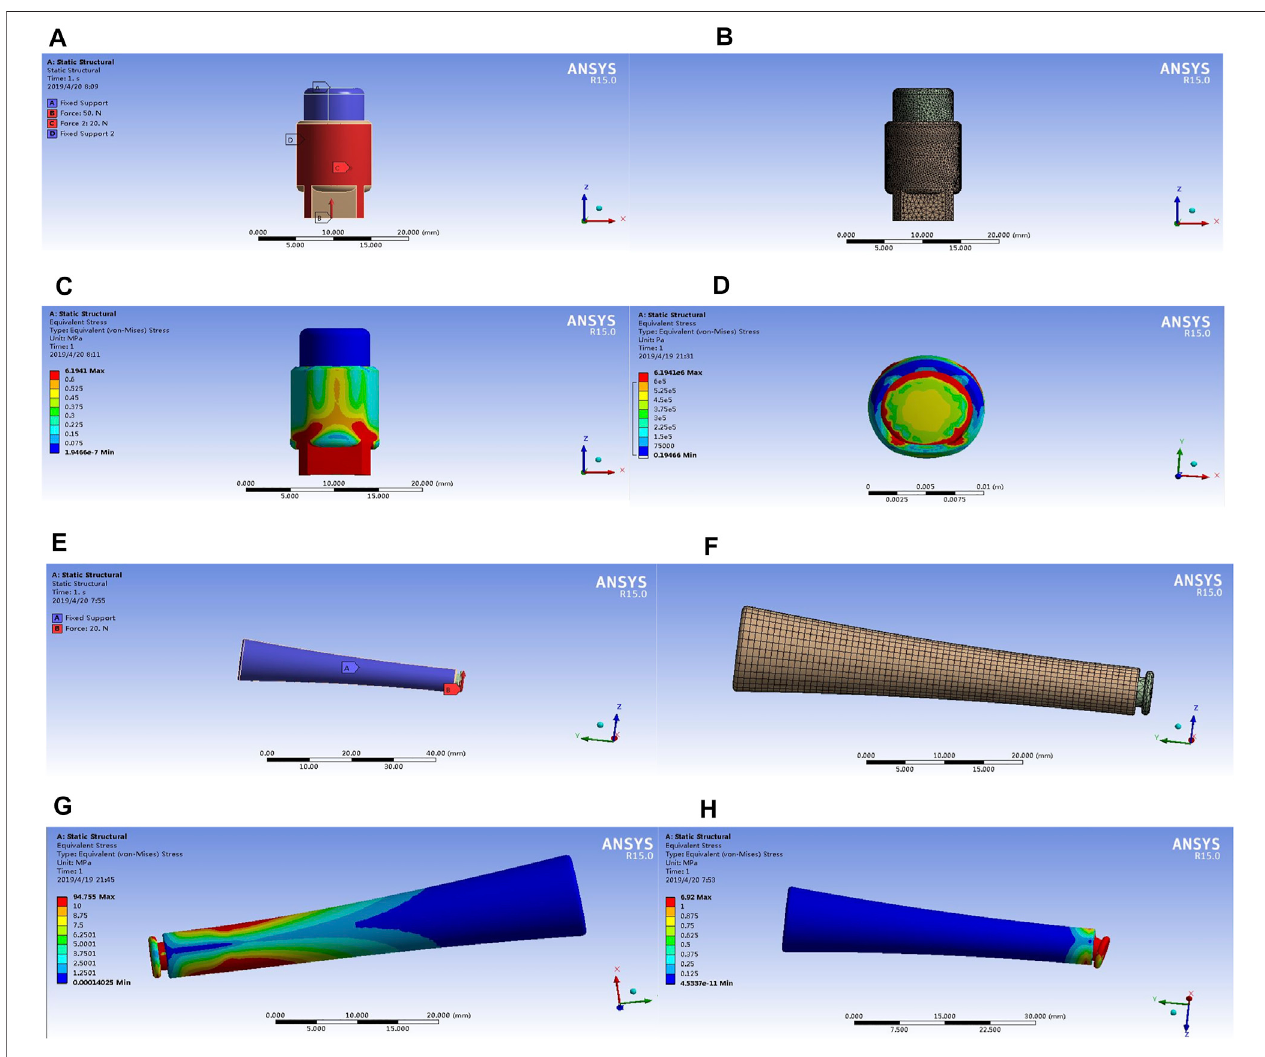
FIGURE 4 | The stress analysis results of the implants with the three-dimensional fi nite element analysis. The results of the external cap implant were shown in Figures 3A – D ; the results of the internal cap implant were shown in Figures 3E – H . Different colors in the color scale represent different stress values. The blue area represents the part with the minimum stress value, and the red area represents the part with the maximum stress.